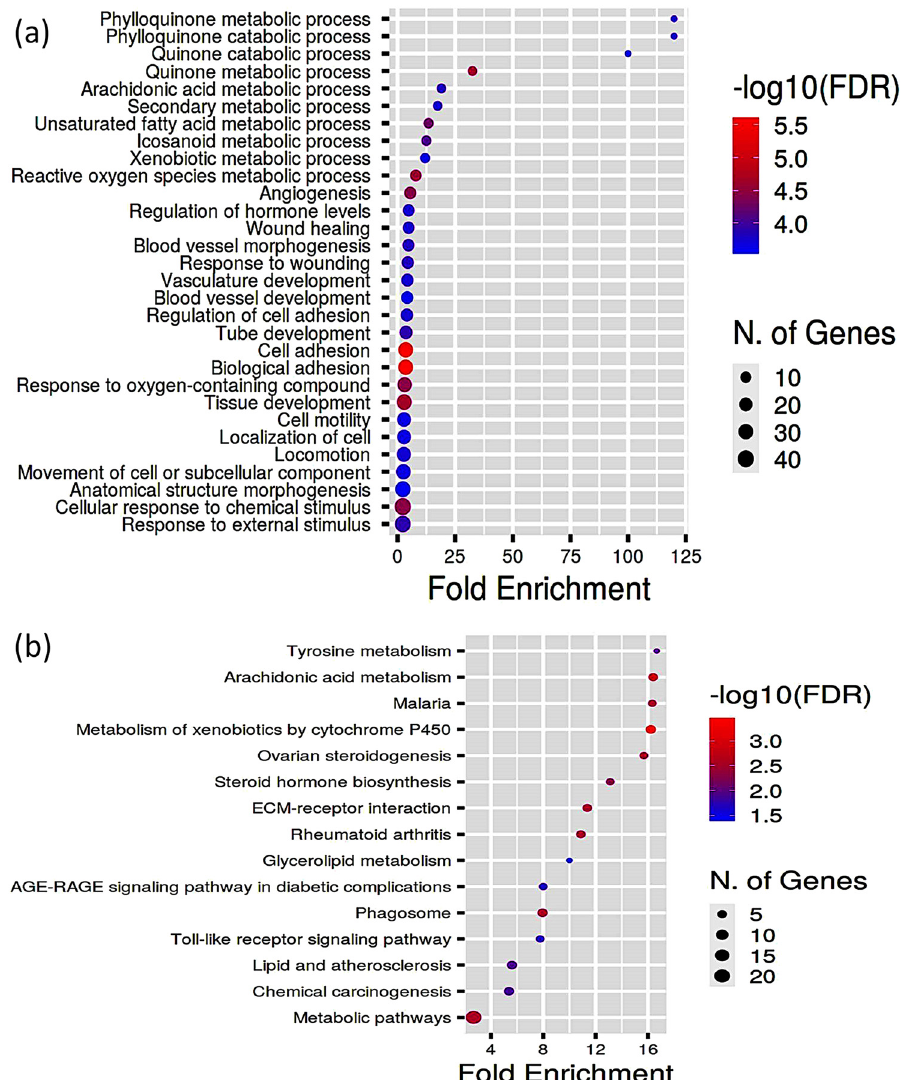
Figure 3: GO enrichment analysis by biological processes ( a ) and KEGG pathways ( b ) for common upregulated DEGs from GSE5058, GSE11784, and GSE11906 datasets. Biological processes and KEGG pathways are ranked by fold enrichment values. The most signi fi cant processes are highlighted in red, and the less signi fi cant processes are highlighted in blue according to log10 ( FDR ) values. Larger dots in the graph indicate a greater number of genes